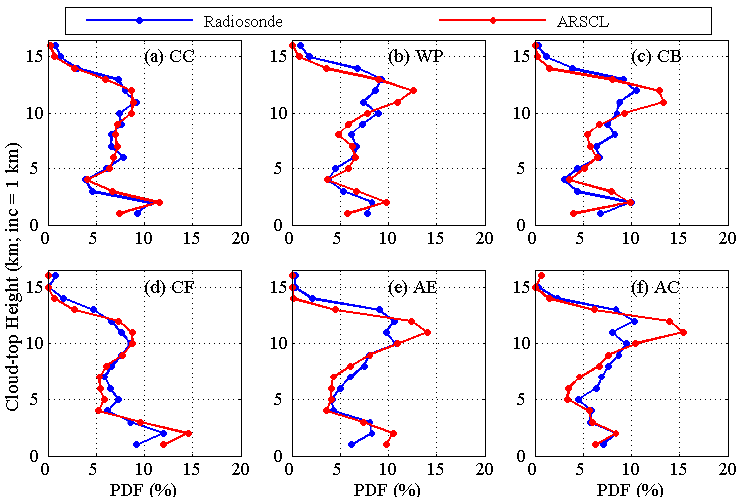
Figure 12. PDF of cloud-top height derived from radiosonde (blue line) and ARSCL (red line) in the synoptic patterns of: CC ( a ); WP ( b ); CB ( c ); CF ( d ); AE ( e ); and AC ( f ) during 2001–2010 at the SGP site. The space interval is 1 km in each panel.